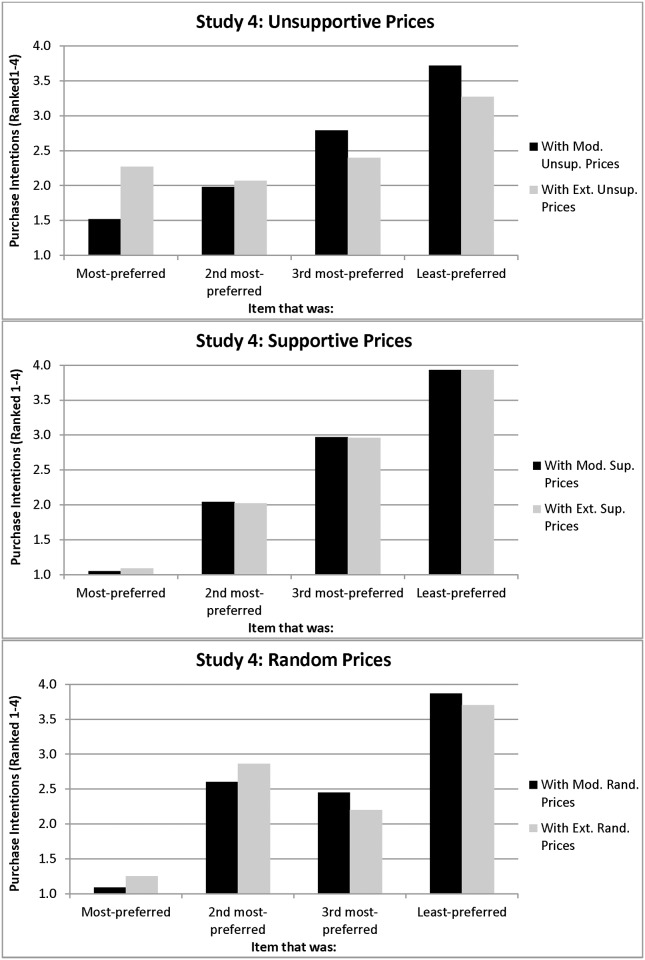
Purchase Intentions as a Function of Preferences in Study 4 (a: unsupportive prices; b: supportive prices; c: random prices).